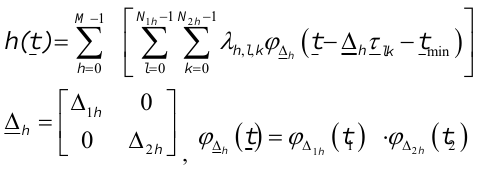
Table 1. Statistics of the sampled datasets. Values in